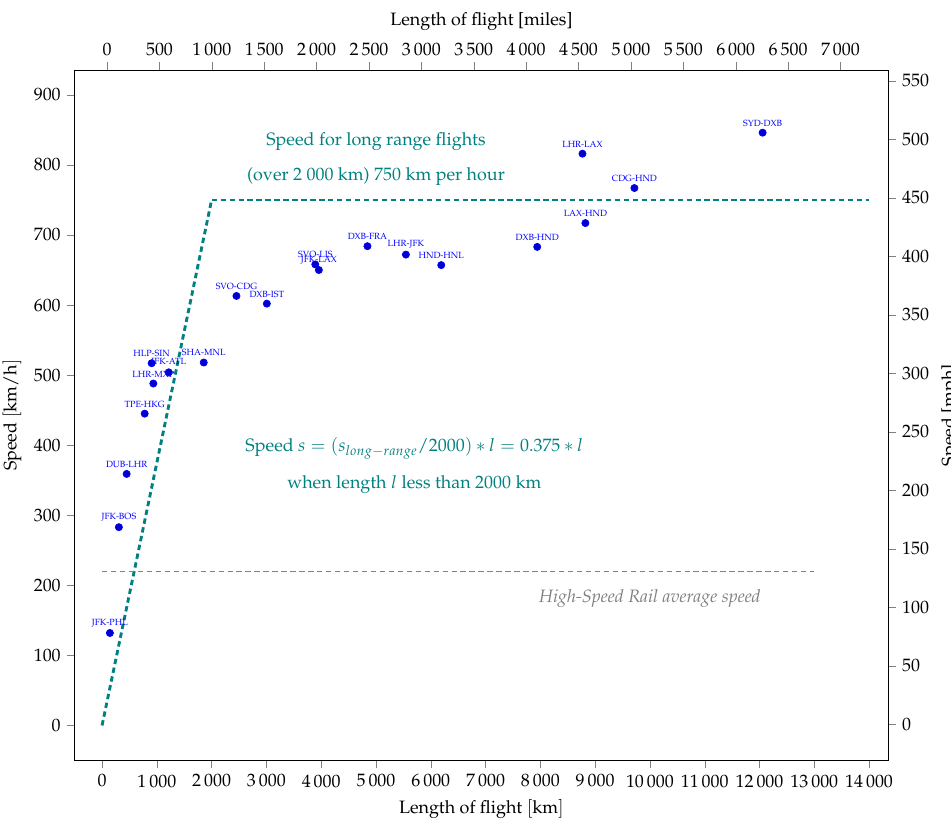
Figure 2. The commercial speed of aircraft services on a sample of origin destination pairs (data from www.flightglobal.com in 2016) and a linear